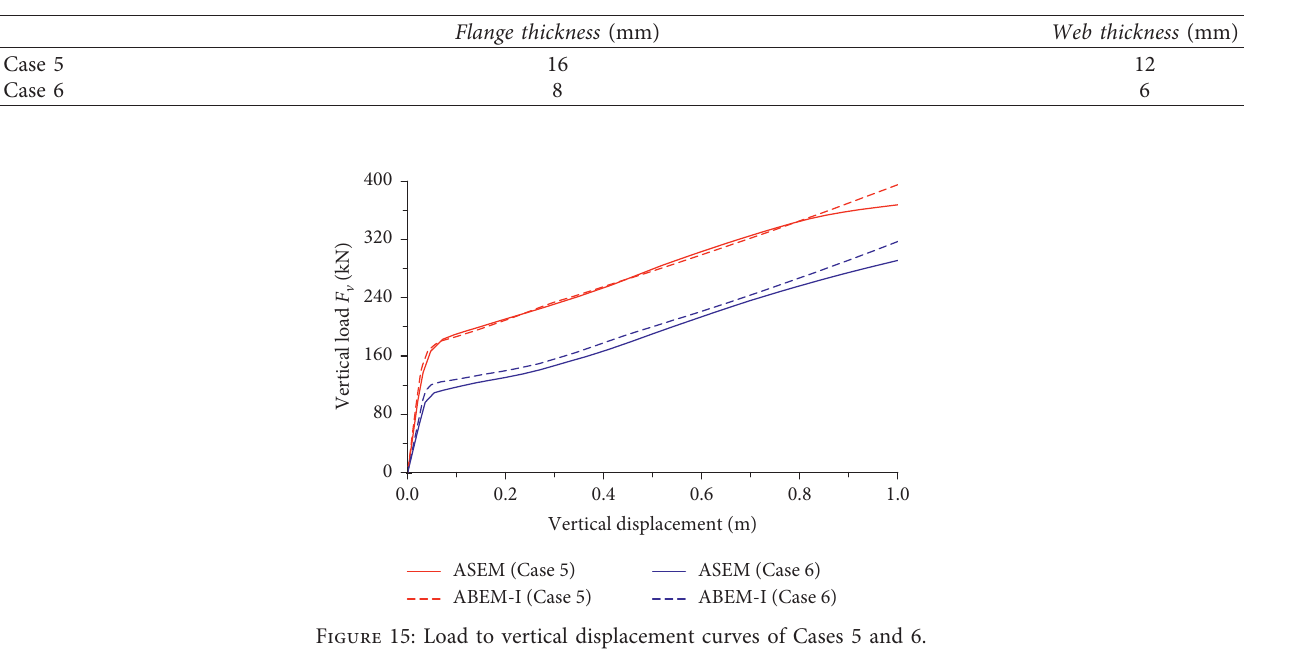
Figure 14: Deformation and local buckling of the ASEM (Case 3). Table 8: The modified thickness of the beam section.